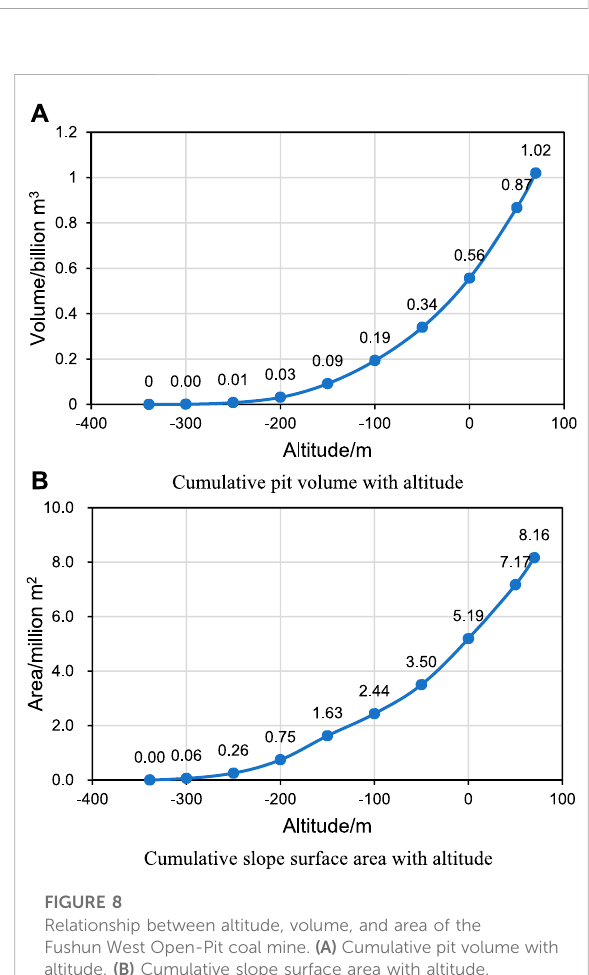
FIGURE 8 Relationship between altitude, volume, and area of the Fushun West Open-Pit coal mine. (A) Cumulative pit volume with altitude. (B) Cumulative slope surface area with